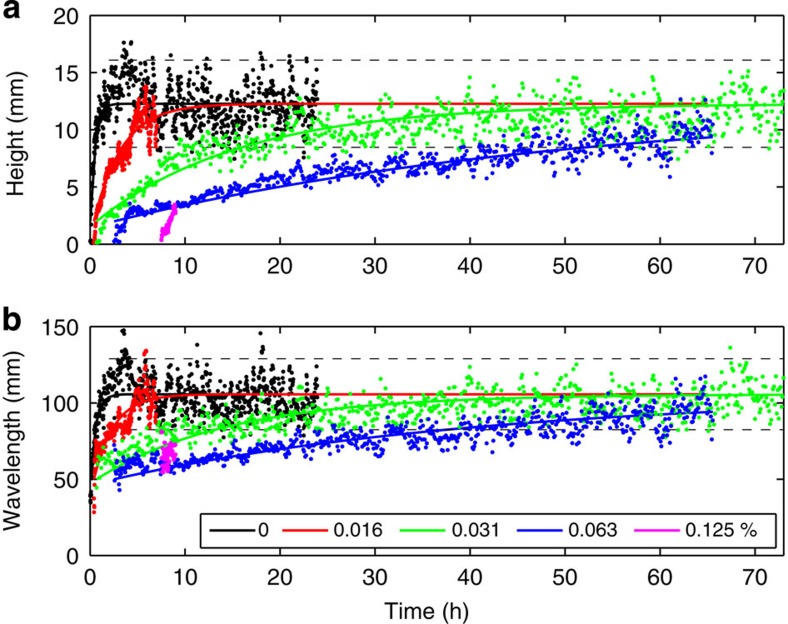
Ripple dimension development curves for the biotic cases.Ripple height (a) and wavelength (b) plotted against time for various initial EPS contents. Lines are based on fitting to equation (1) (ti=0.1, 0.4, 1, 2.7, 7.9 h for initial EPS=0, 0.016, 0.031, 0.063, 0.125%, TH=1.1, 6.9, 35.5, 115.2 h and TL=1.3, 5, 33, 92.2 h for initial EPS=0, 0.016, 0.031, 0.063%) assuming abiotic equilibrium dimensions, He=12 mm, Le=106 mm.